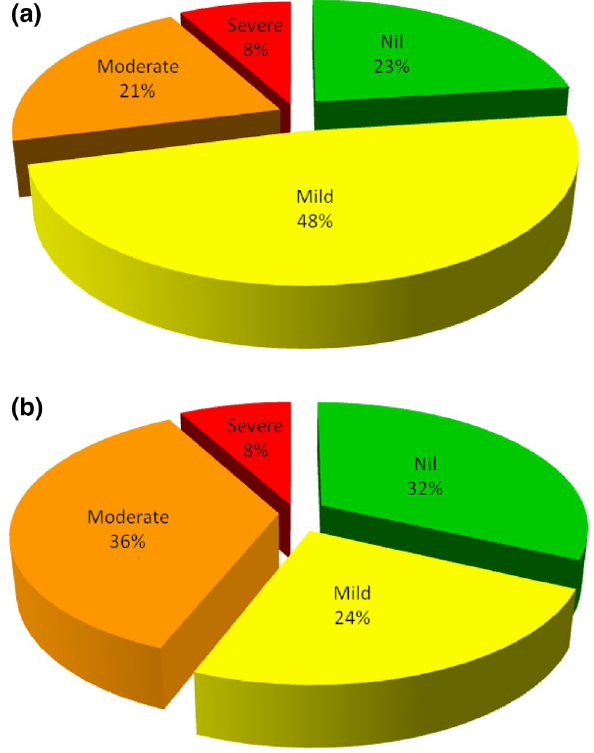
Fig. 1 Prevalence of fluorosis (%) among girls ( a ) and boys ( b ) in the present study ( n = 25 in